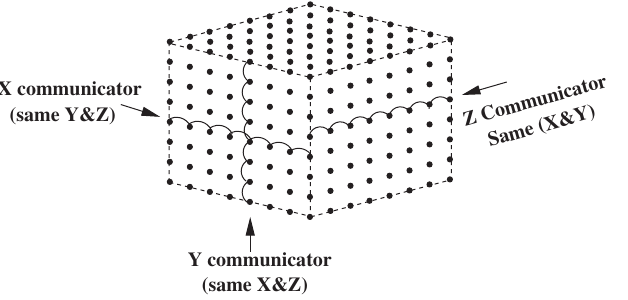
FIG. 3. Definition of three communication groups, one in X , one in Y , and one in Z